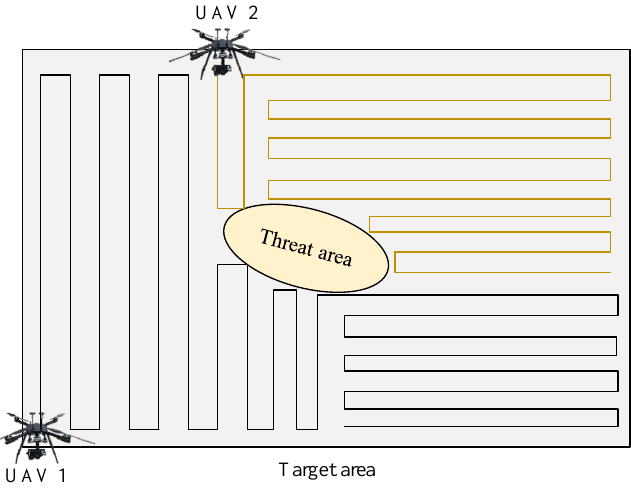
Figure 5. CPP in Coverage